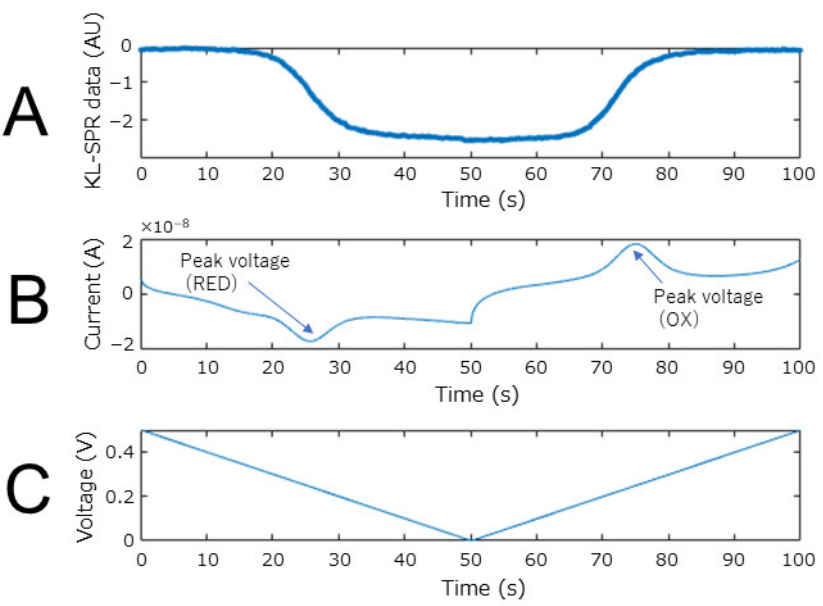
Figure 6. Change in KL-converted SPR curve data when sweeping the potential. ( A ) KL-converted SPR curve data. KL-converted SPR data value was normalized using the 0.5 V value and 0.25 V value. ( B ) Current change detected by potentiostat. ( C ) Electronic sweep.